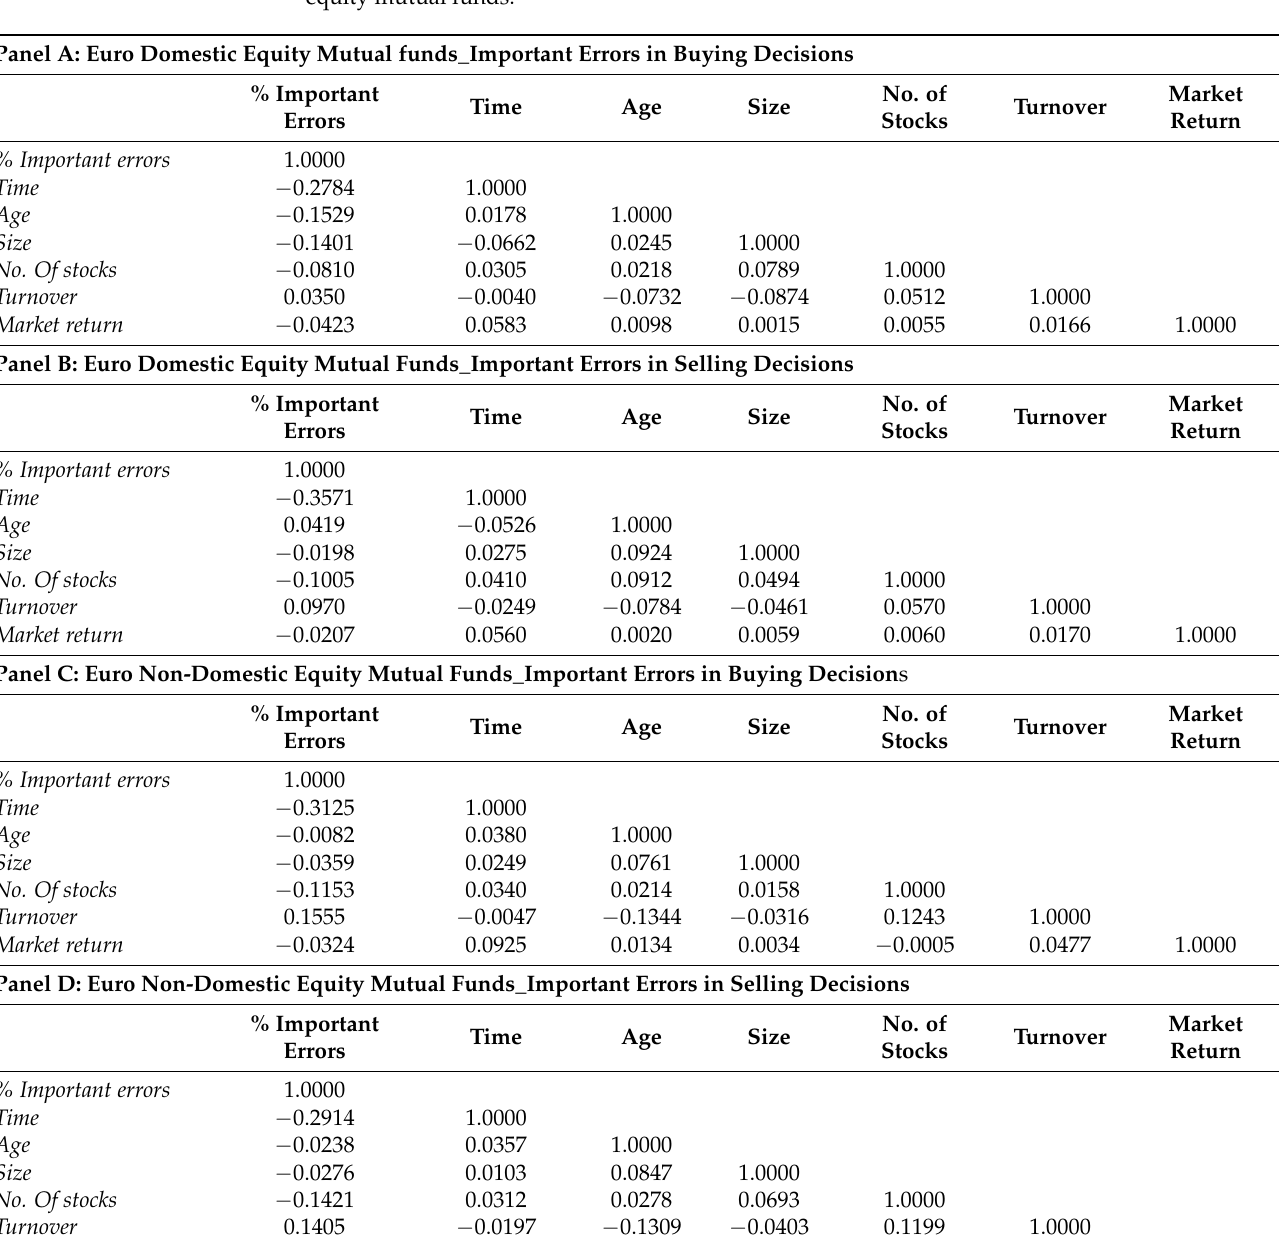
Table A2. Correlation matrixes. This table shows the results of the correlation matrixes between the dependent and independent variables included in Equations (14) and (15). Panels A and B present the correlation matrixes for Euro domestic equity mutual funds with important errors in buying and selling decisions, respectively. Panels C and D present the same information for Euro non-domestic equity mutual